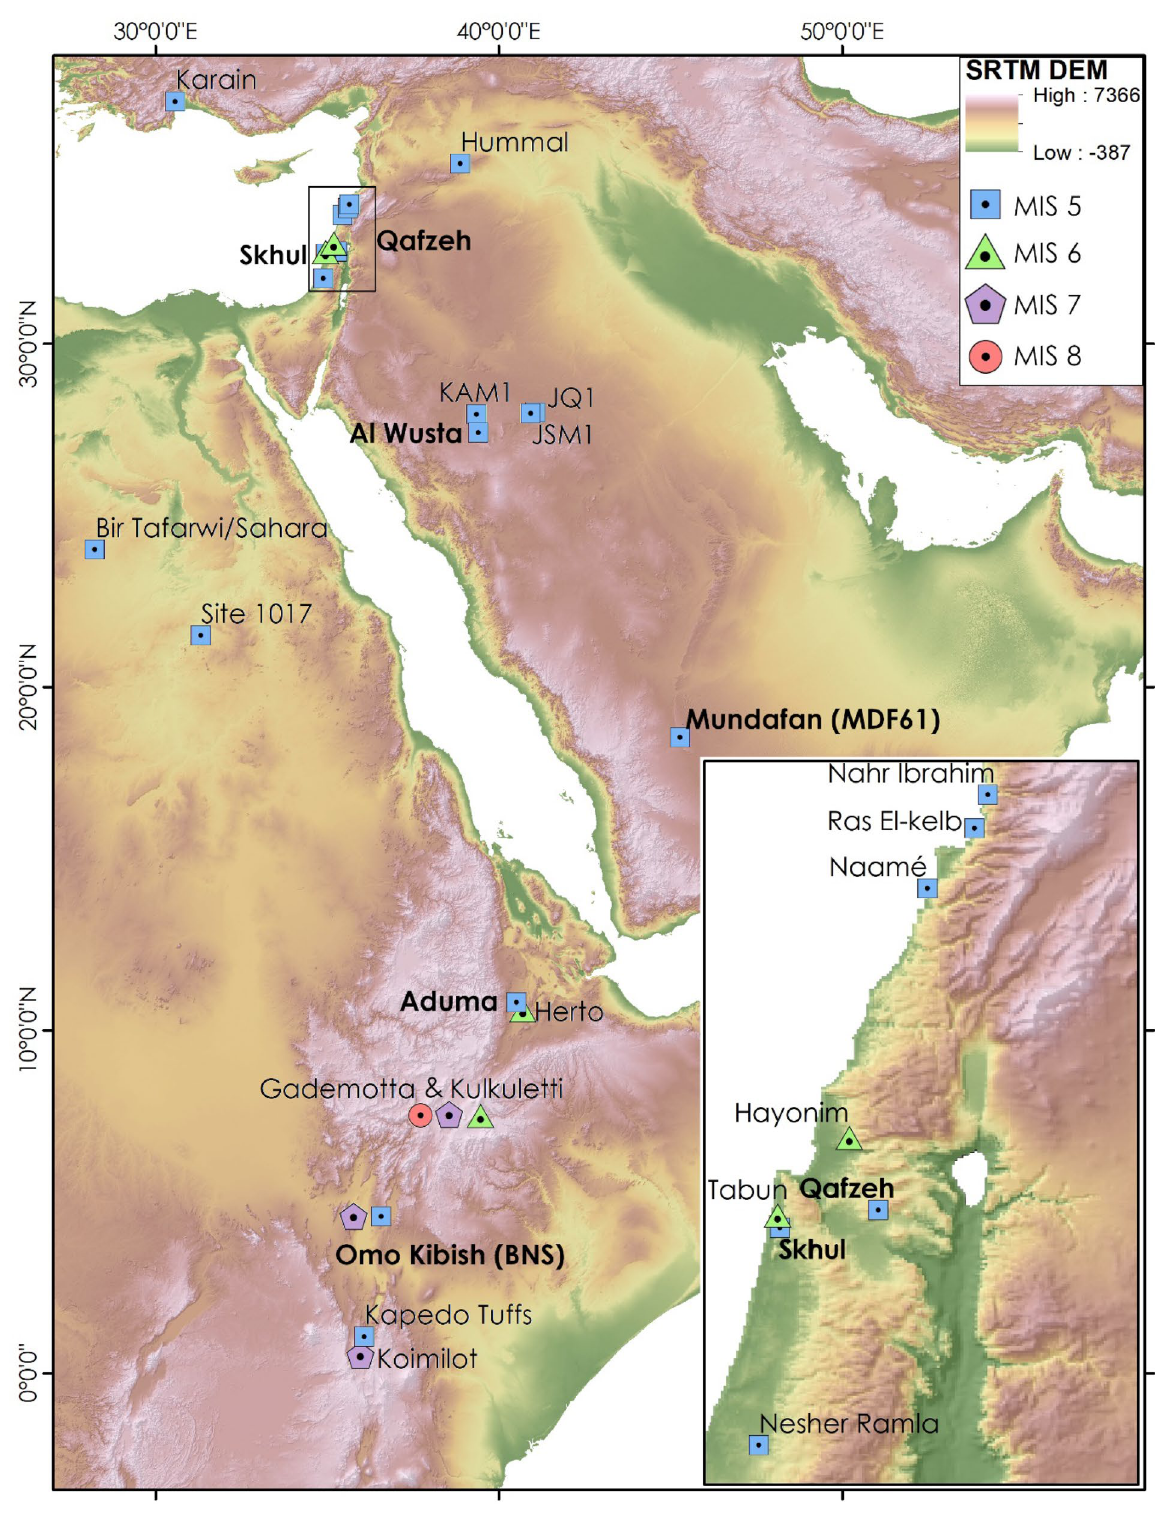
Figure 1. Map illustrating the distribution of sites studied here (named in bold) among sites with a prominent use of centripetal Levallois reduction (following Prévost and Zaidner 20 ). A concentration of assemblages dating between MIS 8–6 is identified in eastern Africa, followed by more widespread appearance across Eastern/North- East Africa and Southwest Asia in MIS 5. Inset is a closeup of the central Levant. Data: SRTM (NASA) 25 . Figure produced using ArcMap 10.5 and GIMP